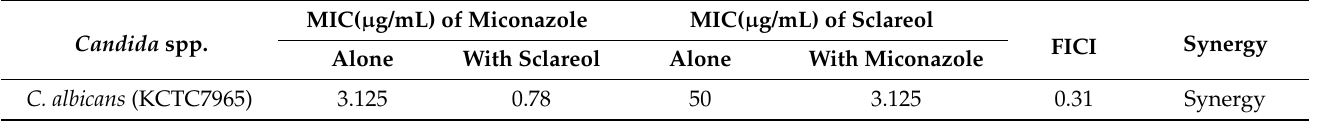
Table 4. Sclareol synergistically inhibited the growth of C. albicans with miconazole.